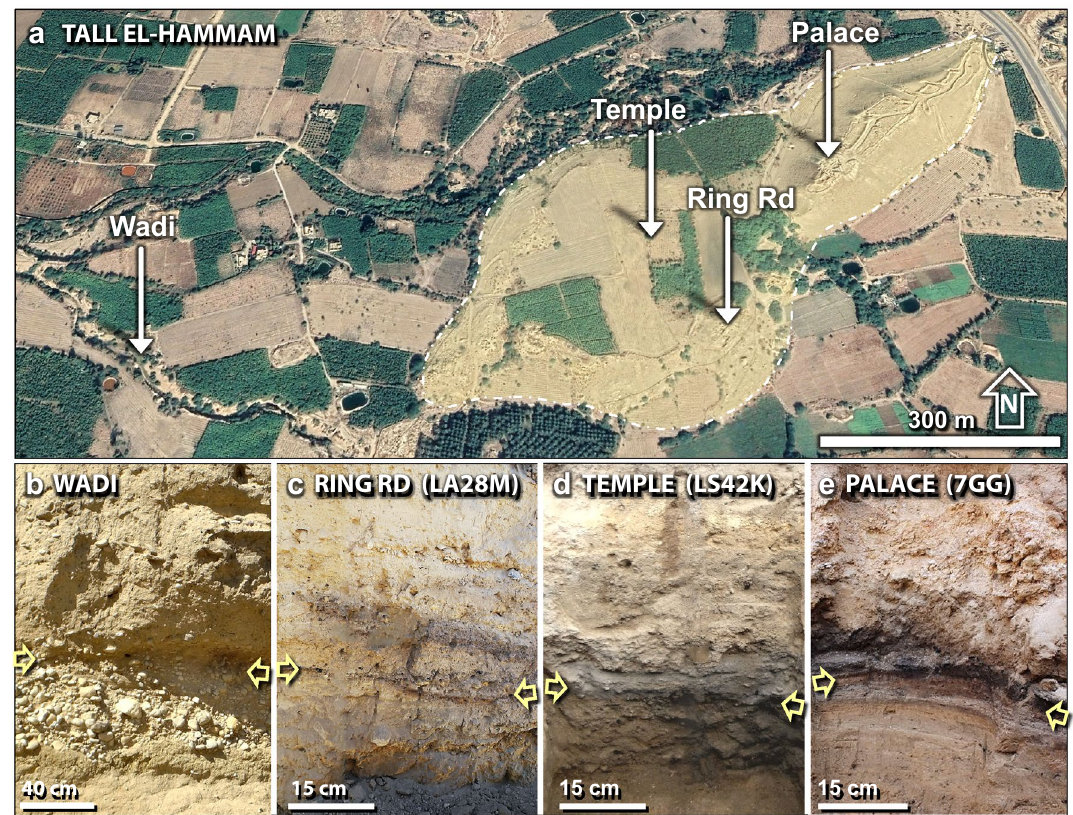
Figure 4. Sedimentary profiles. ( a ) Map of the city (white dashing line) showing sampling locations, spanning ~ 1100 m. Source of base image: “Tall el-Hammam”. 31° 50.483 N, 35° 40.029 E. Google Earth; CNES/ Airbus. Imagery date: 11/26/2019; accessed: 4/4/2021. ( b ) The wadi; ( c ) the ring road in Field LA; ( d ) the palace in Field LS; and ( e ) the palace in Field UA. In the wadi, yellow arrows mark the level of the 3600-year-old stratum. Inside the city, the arrows mark the location of the charcoal-and-ash-rich dark